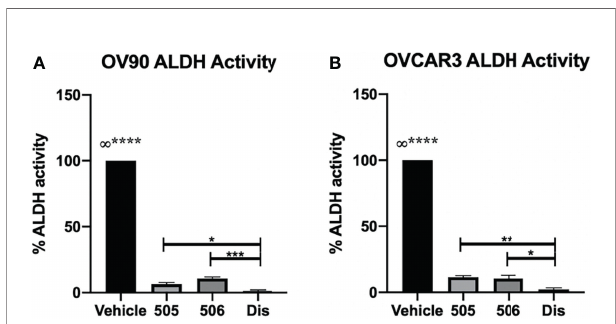
FIGURE 2 | ALDH inhibitors signi fi cantly reduced ALDH activity; disul fi ram reduced activity signi fi cantly more than NCT-505 and -506. ALDH activity after treatment with calculated viability IC 50 of NCT-505, NCT-506, and disul fi ram determined in (A) OV90 and (B) OVCAR3 TICs via fl ow cytometry following ALDEFLUOR protocol. Graphs represent mean and SEM of each treatment, from 3 independent experiments, ∞ , compared to all groups, *p <0.05, **p < 0.01, ***p < 0.001, ****p < 0.0001, compared to